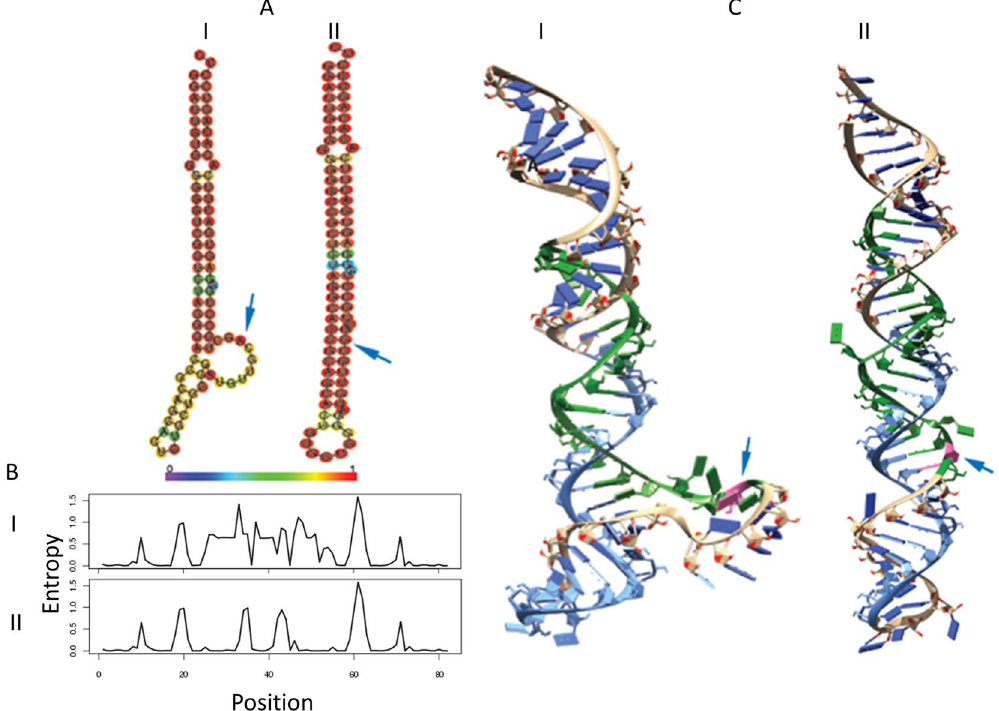
Figure 5. The two- and three-dimensional analysis for a representative pre-miRNA (mir-1301) unedited and edited sequence. ( A ) The minimum free energy secondary structures and its sequences, colored according to the base-pairing probability. The structure was predicted using RNAFold which uses a loop-based energy model and the dynamic programming algorithm. ( B ) The corresponding positional entropy for each position. ( C ) The lowest free energy three-dimensional structure was built using mcfold followed by mcsym where the RNAFold’s secondary structure information was given as structural constrain for unpaired nucleotides. The 5p arm is colored as blue while the 3p arm is colored green, with the edited nucleotide colored as pink. ‘I’ represent the unedited form while ‘II’ represents the edited form. The arrows mark the site of editing. The minimum free energy change at the two- and three dimensional levels for the unedited and edited pre-mirna-1301 is provided in Supplemental Table S5A.